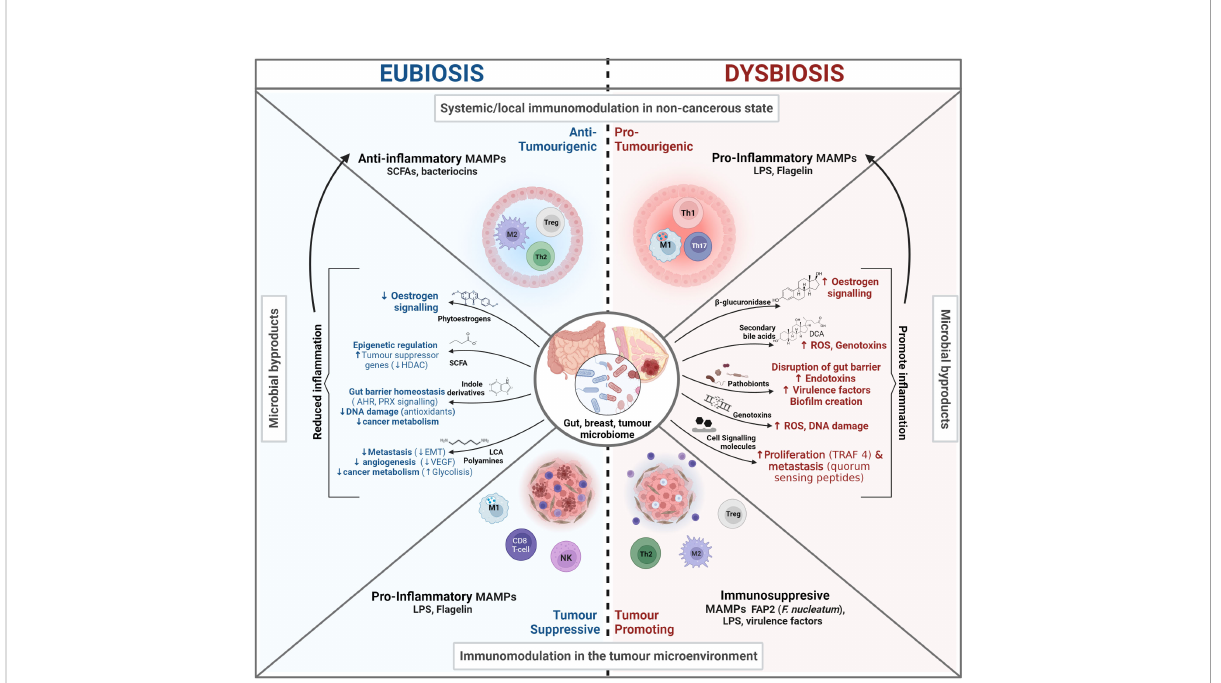
FIGURE 1 The microbiome in fl uence in Cancer. In eubiosis the microbiome promotes our health status and prevents oncogenesis and tumor progression by in fl uencing the immune system, promoting gut barrier integrity, and in fl uencing cell signaling. Conversely, during dysbiosis there is a loss of barrier integrity that can lead to potentially harmful bacterial translocation, chronic in fl ammation in distal sites and the production of cancer promoting bacterial